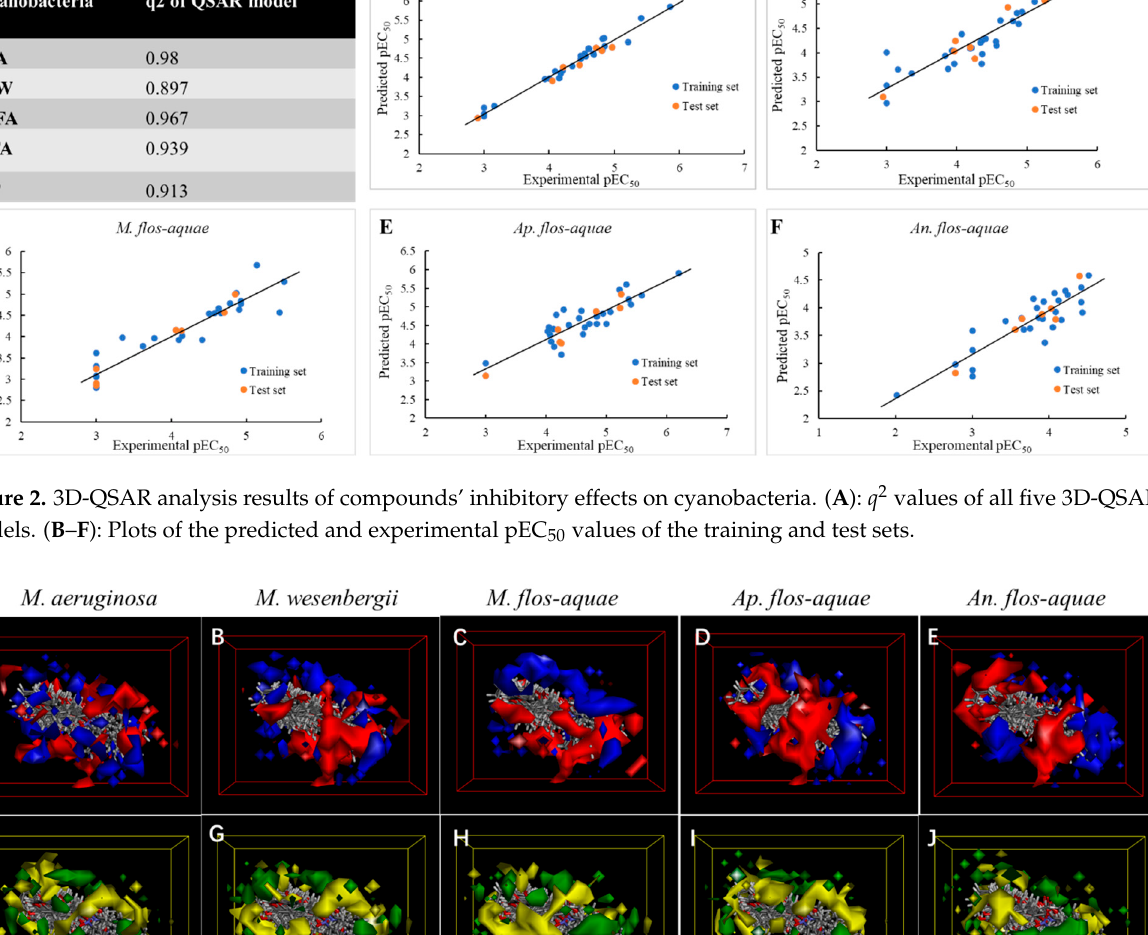
Figure 4. Superoxide dismutase (SOD) activity ( A ), and contents of soluble protein ( B ) and malondialdehyde (MDA) ( C ) in M. aeruginosa after 72-h exposure to compound 24 and CIA (0, 1.25, 2.5, and 5 µmol/L). Data are presented as mean values ± standard deviation (n = 3). * p < 0.05, ** p < 0.01, *** p < 0.001 vs. 0 µmol/L. The changes of soluble proteins in M. aeruginosa in the exposure experiment are shown in Figure 4B. The soluble protein content in M. aeruginosa did not change signifi- cantly after treatment with CIA for 72 h. After the 72-h treatment of compound 24 on M. aeruginosa , only when the concentration increased to 5 µmol/L did the soluble protein con- tent decrease by 27.46%. This result indicated that the main mechanism of compound 24